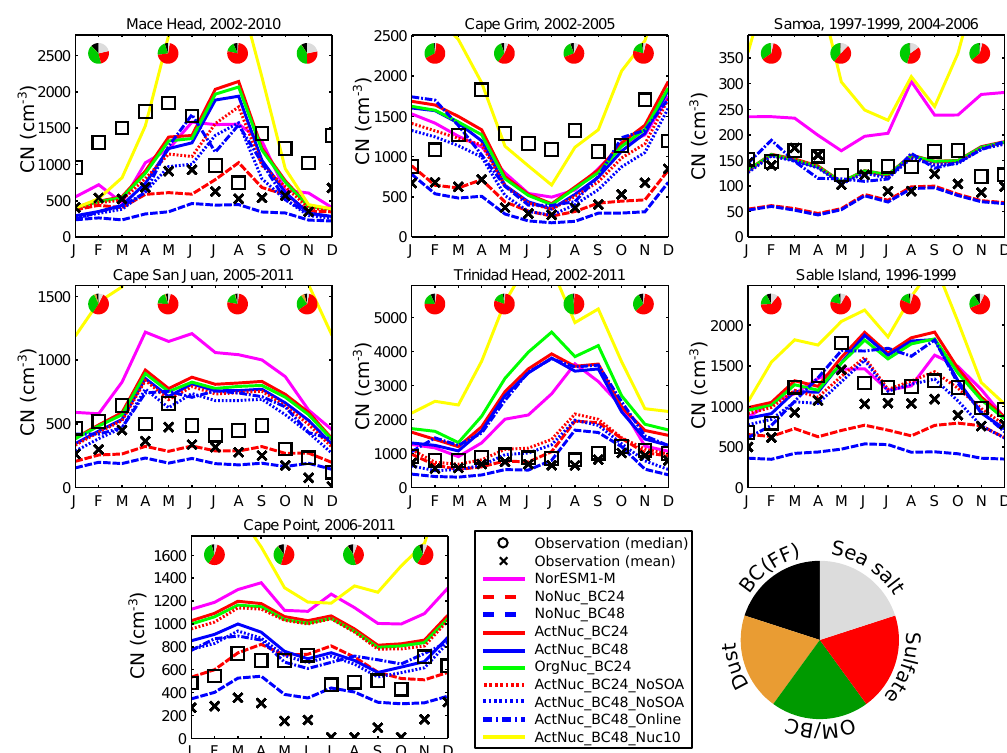
Figure 6. As Fig. 5, but for marine